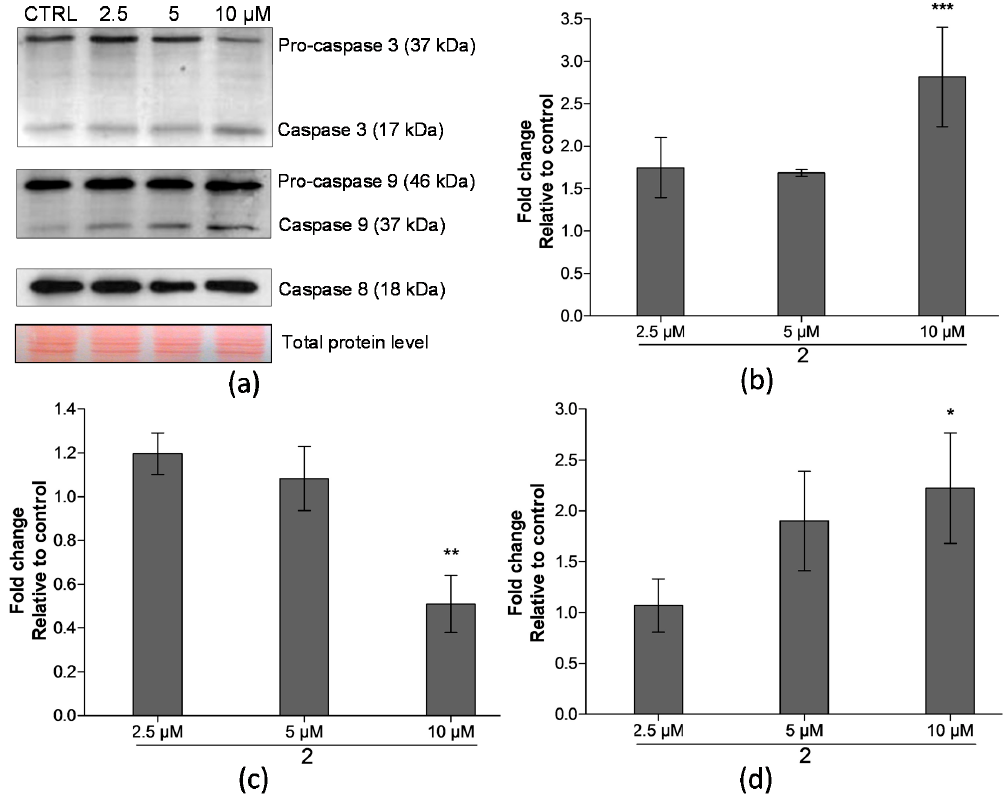
Figure 6. Levels of proteins involved in apoptotic pathways in THP-1 cells after 24 h treatment by